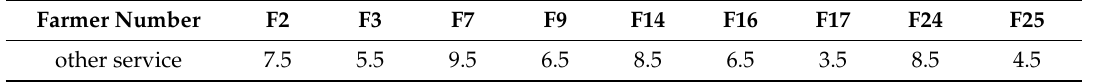
Table 8. Assessment of the selected service facility (other service